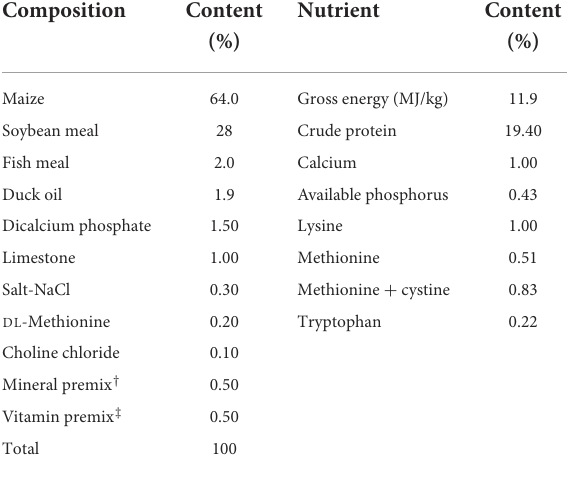
TABLE 1 Formulation and proximate composition of the basal